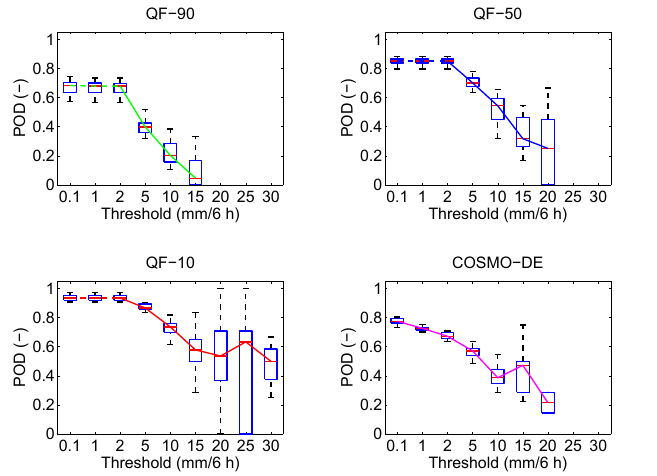
Figure 5. False Alarm Rate (FAR) according to thresholds of areal precipitation sums ranging from 0.1 to 30mm/6h for the Quantile Forecast and COSMO-DE from April 2011 to June 2014. The box plots indicate the spread of FAR over the 16 forecast